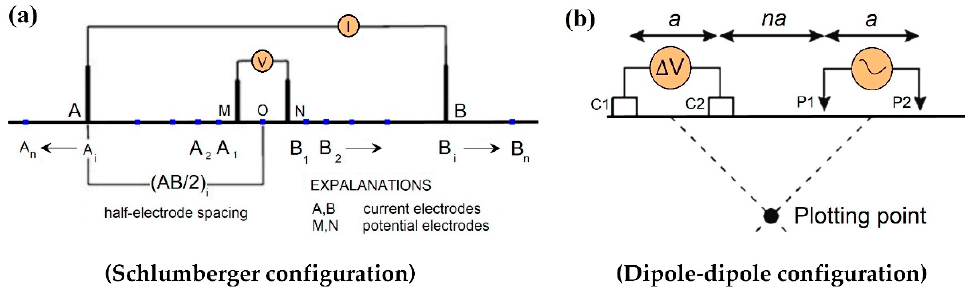
Figure 5. Schematic diagram of ( a ) the Schlumberger array configuration for vertical electrical sounding (VES), and ( b ) dipole–dipole array configuration for electrical resistivity tomography (ERT) techniques.